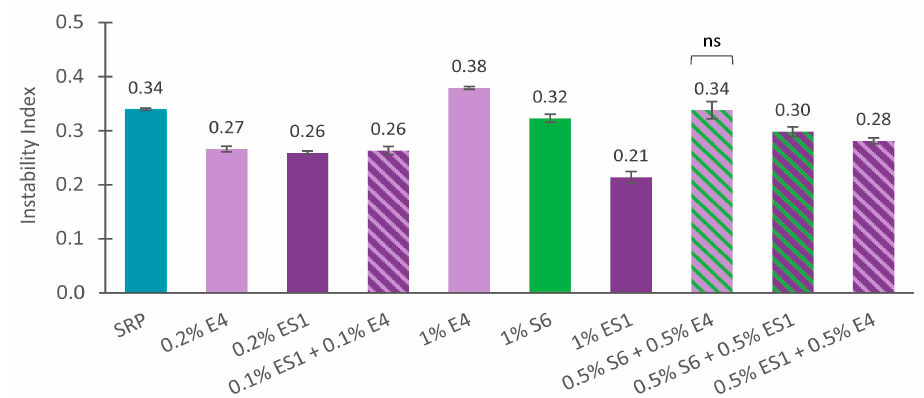
Figure 4. Instability index of SRP with different combinations of dispersing agents and comparison with the dispersing agents added individually (6 h at 300× g ). Refer to Tables 1–4 for dispersing agent labels. Error bars depict sampling error. Values are significantly different from the control SRP ( p < 0.01) except for the nonsignificant result (ns).